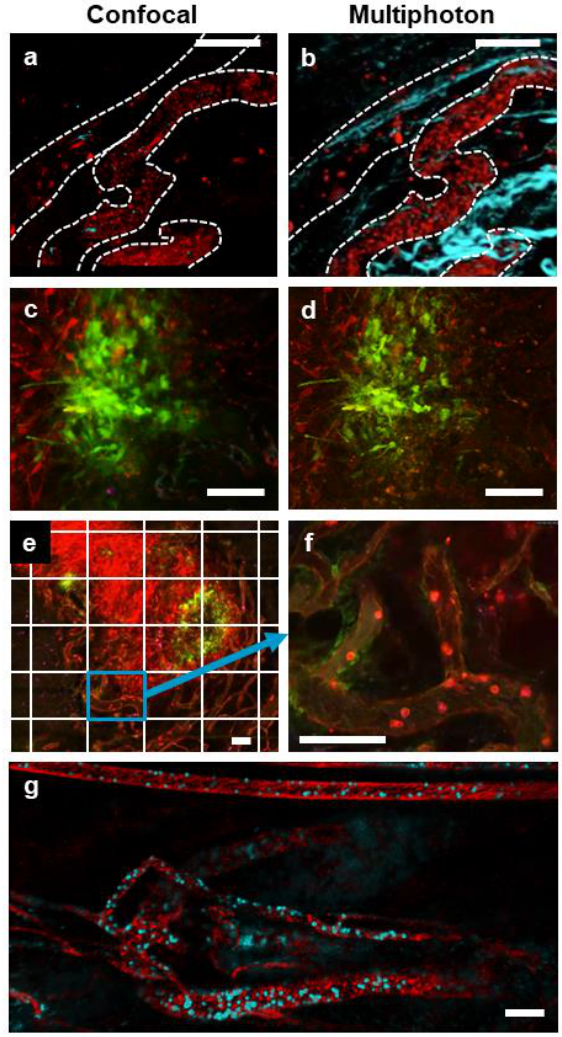
Figure 2. IVM of tumor vasculature acquired with resonant scanning confocal or multiphoton imaging modalities. Representative images of a single field of view showing a subcutaneous CT-26 tumor vasculature (red; phycoerythrin (PE)-conjugated anti-CD31 and PE-conjugated anti-CD49b, blood vessels are denoted by a dotted white outline) captured with either confocal ( a ) or multiphoton ( b ) imaging (collagen appears blue as a result of second-harmonic generation). In the confocal image ( a ), some CD8+ cells (blue; eFluor 660-conjugated anti-CD8α) are visible; however, these cells are not seen in the multiphoton image ( b ) because of a lack of fluorophore stimulation by the single multiphoton excitation wavelength used in this imaging. Confocal ( c ) and multiphoton ( d ) imaging of a subcutaneous CT-26 tumor (red) infected with VSV that is transgenic for GFP (VSV ΔM51-GFP ; green). A stitched, tile scan image ( e ) of an entire subcutaneous CT-26 tumor (bright red) demonstrating localized VSV infection (green) was captured using resonant scanning confocal imaging. Note each tiled image (outlined by the white grid) was captured as a high-resolution video ( f ) allowing for later analysis at the cellular level (neutrophils in bright red, endothelium in dim red, i.v.-delivered eFluor 660-labelled VSV ΔM51-GFP in blue). High-resolution 4D movies of stitched images ( g ) of the tumor vasculature of a rhabdomyosarcoma within the gastrocnemius muscle (red; PE-conjugated anti-CD31 and PE-conjugated anti-CD49b), containing neutrophils (cyan; BV421-conjugated anti-Ly6G) captured using multiphoton microscopy. The white scale bar represents 100 µ m. Images in ( a , c , e , f ) were captured using resonant scanning confocal microscopy, whereas images in ( b , d , g ) were captured using resonant scanning multiphoton